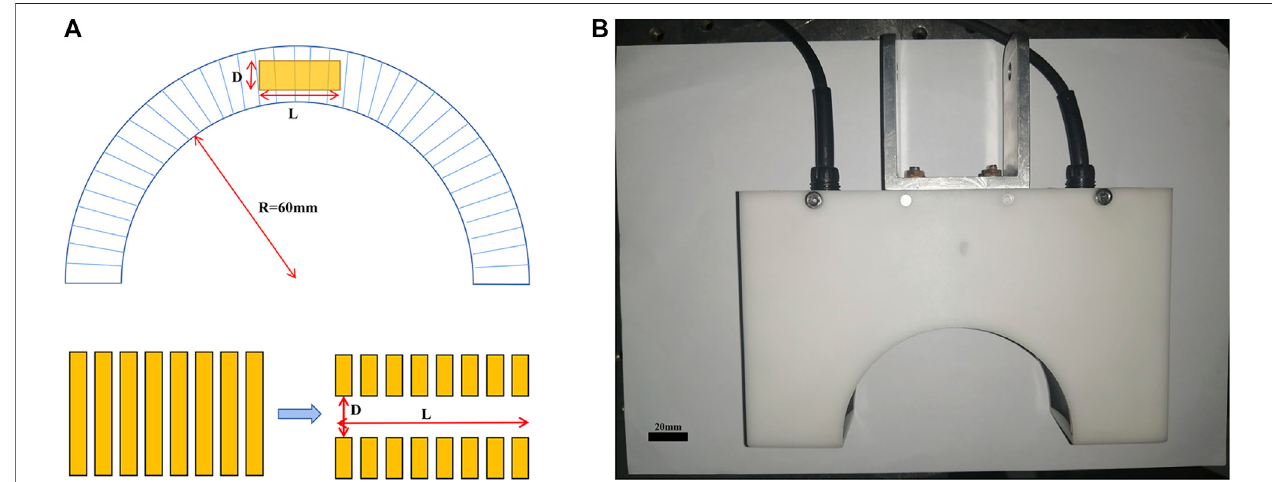
FIGURE 3 | (A) Structure diagram of circular array; (B) physical picture of the circular array.